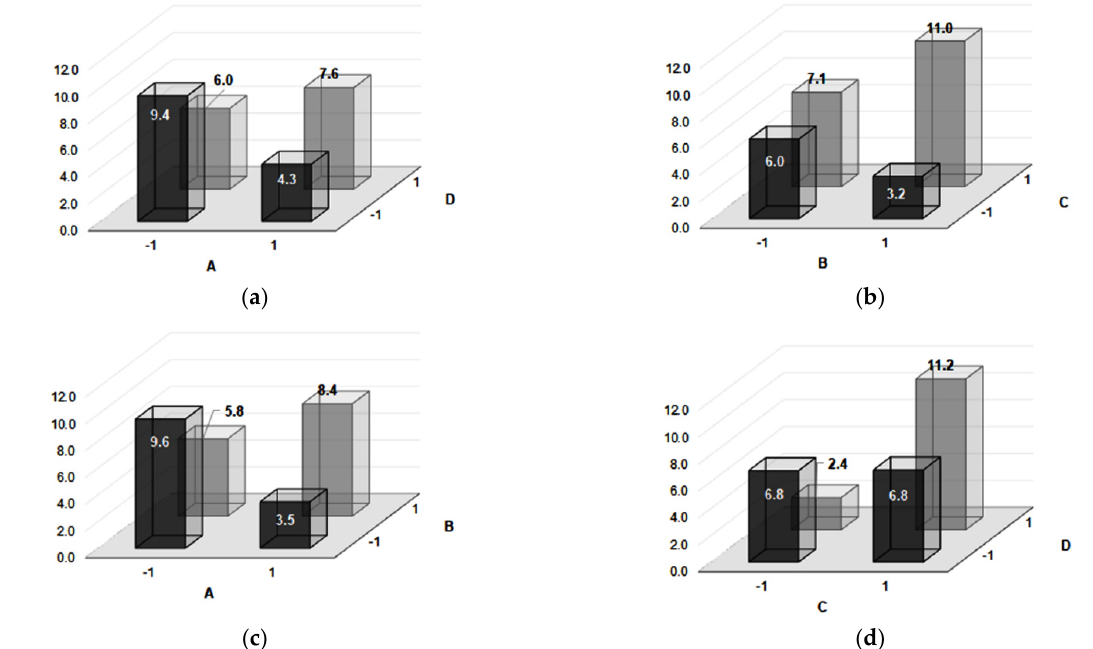
Figure 11. Analysis of the interactions with a significant effect on toughness of material, characterised with the Hounsfield test. X-axis represents the two levels of A-factor (figure ( a )), of B-factor (figure ( b )), of A-factor (figure ( c )), and C-factor (figure ( d )). Y-axis represents the two levels of D-factor (figure ( a )) of C-factor (figure ( b )), of B-factor (figure ( c )), of D-factor (figure ( d )). Z-axis represents the effect of each possible combination: ( a ) interaction AB; ( b ) interaction CD; ( c ) interaction AD; ( d ) interaction BC.